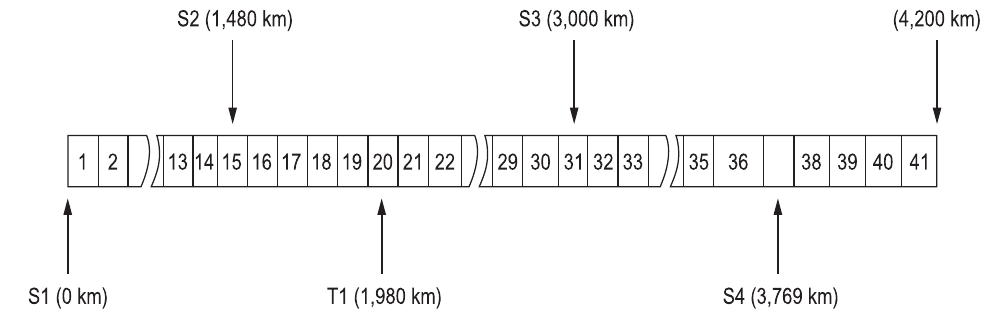
Figure 5. Discretization of the Fidalgo stream. Table 1. Hydraulic characteristics of the monitoring Stations along the Fidalgo stream.